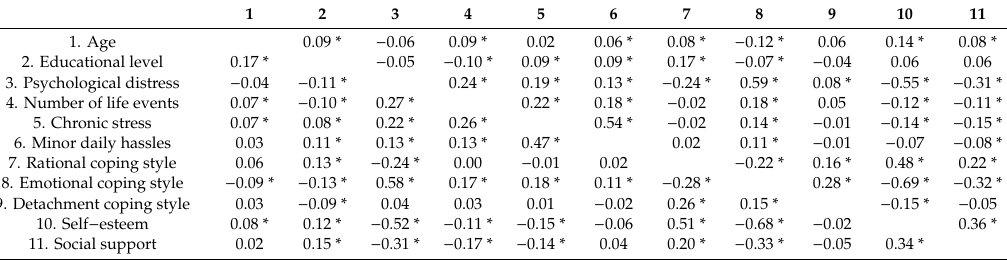
Table 2. Correlations among the study variables for the groups of men and women. Correlations for men are above the diagonal; correlations for women are below the diagonal.